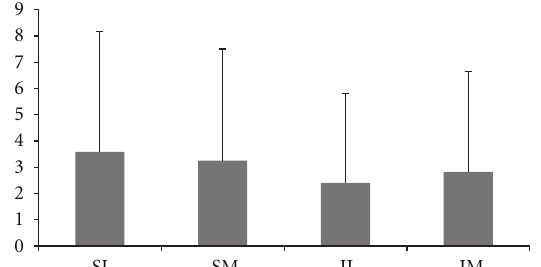
Figure 4: Average superficial nodes distribution versus quarters; SL: superolateral; SM: superomedial; IL: inferolateral; IM: inferomedial quarters. No statistically di ff erence between